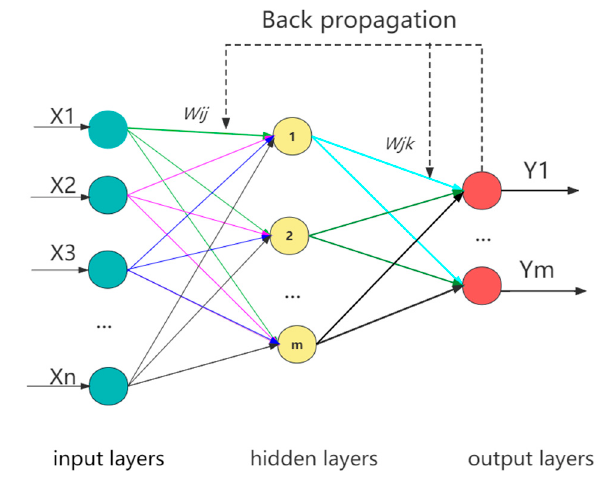
Figure 1. BP neural network topology.